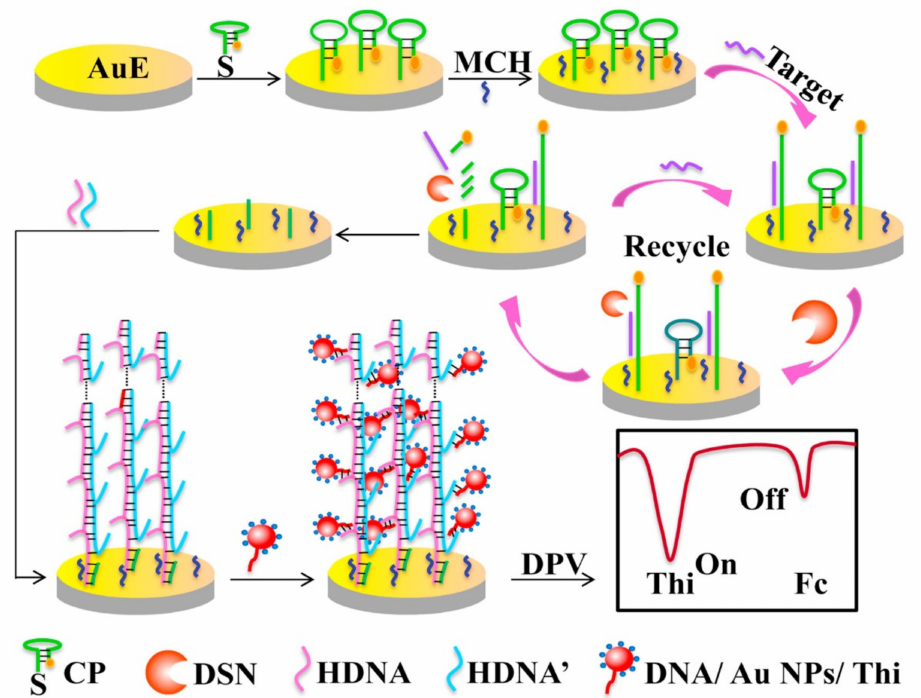
Figure 6. Schematic diagram illustrating the ratiometric electrochemical assay for miR-141 detection based on DSN and HCR amplification. Reprinted from [72] with permission from